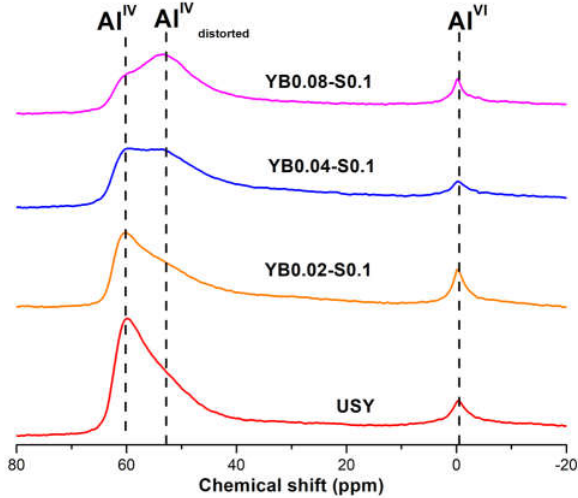
Figure 11. 27 Al nuclear magnetic resonance (NMR) spectra of the calcined modified zeolites produced using different alkaline medium concentrations.